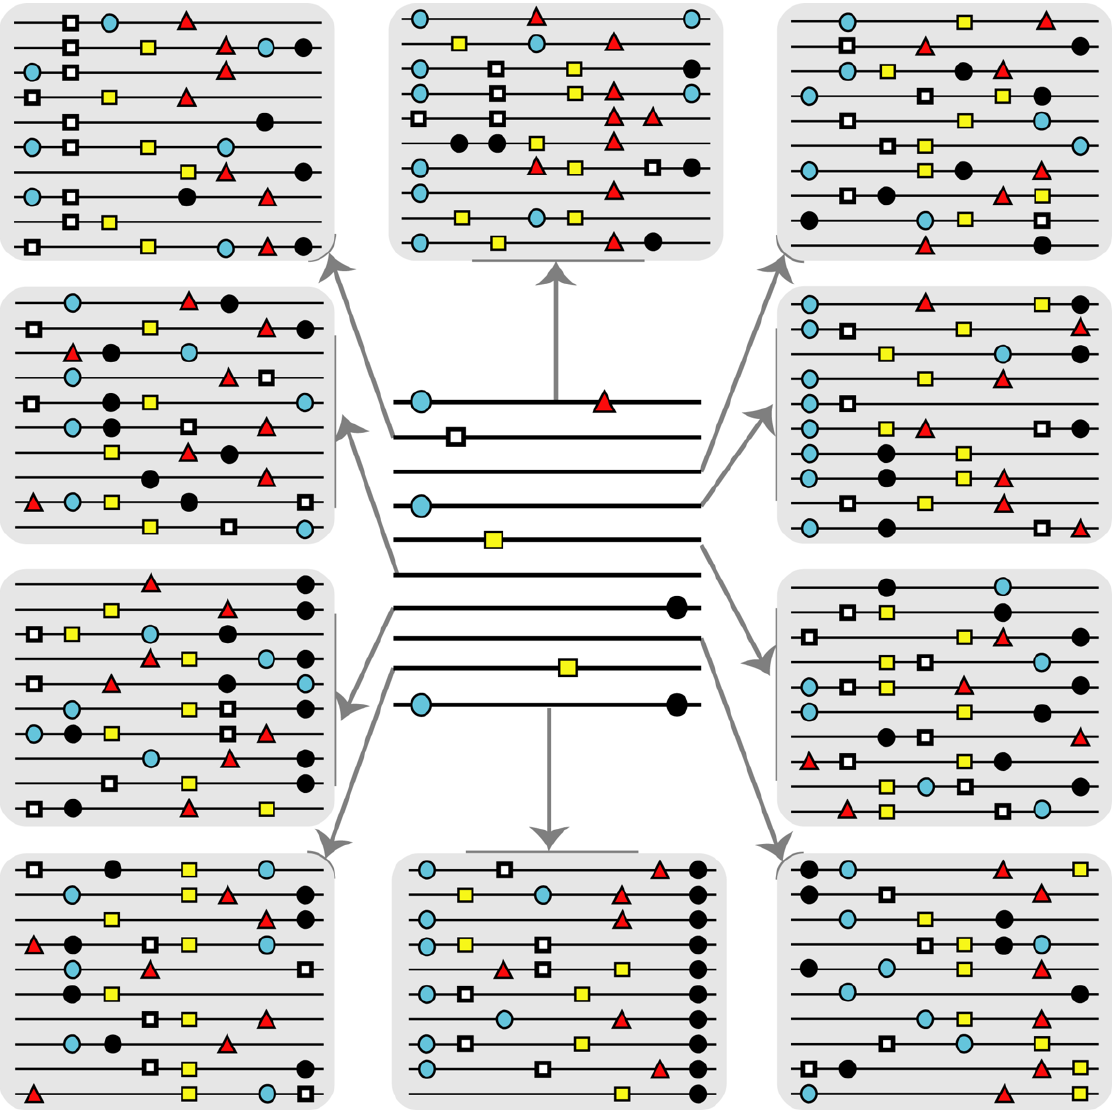
Figure 6. Scheme that illustrates the interest of incorporating information retrieved from mutant spectra into data bases for viruses. Each horizontal line represents a nucleotide or amino acid sequence with mutations or amino acid substitutions represented by symbols on the lines. Variations are relative to a reference sequence that in this case is a line without symbols. The center distribution describes an alignment of consensus sequences or sequences currently available in data banks. Each line is in reality an average of many different sequences with mutations additional to those included.